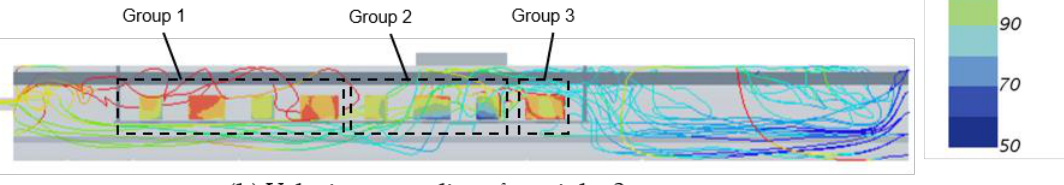
Figure 12. Velocity streamlines from inlets 1, 2, and 3 for the underfloor equipment bay (Configuration 2).